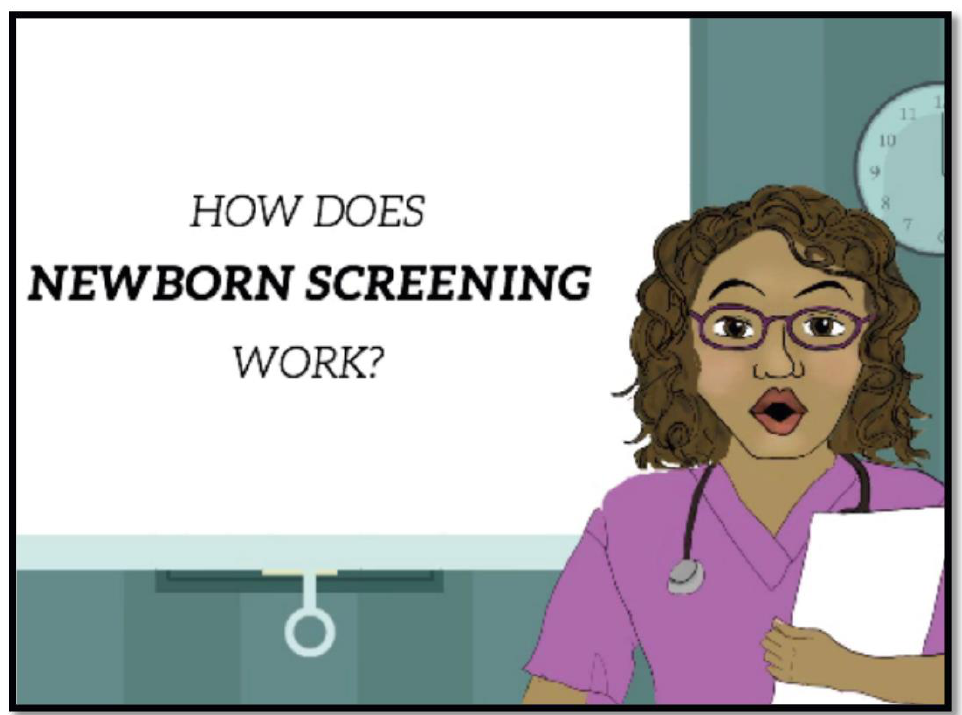
Figure 1. Still Image from the introductory video featuring “Nurse Maria” and explaining. the process and benefits of newborn screening Full video available at https://www.youtube.com/watch?v=2qeBX0FDp_I&t=3s [last accessed on 25 July 2022].